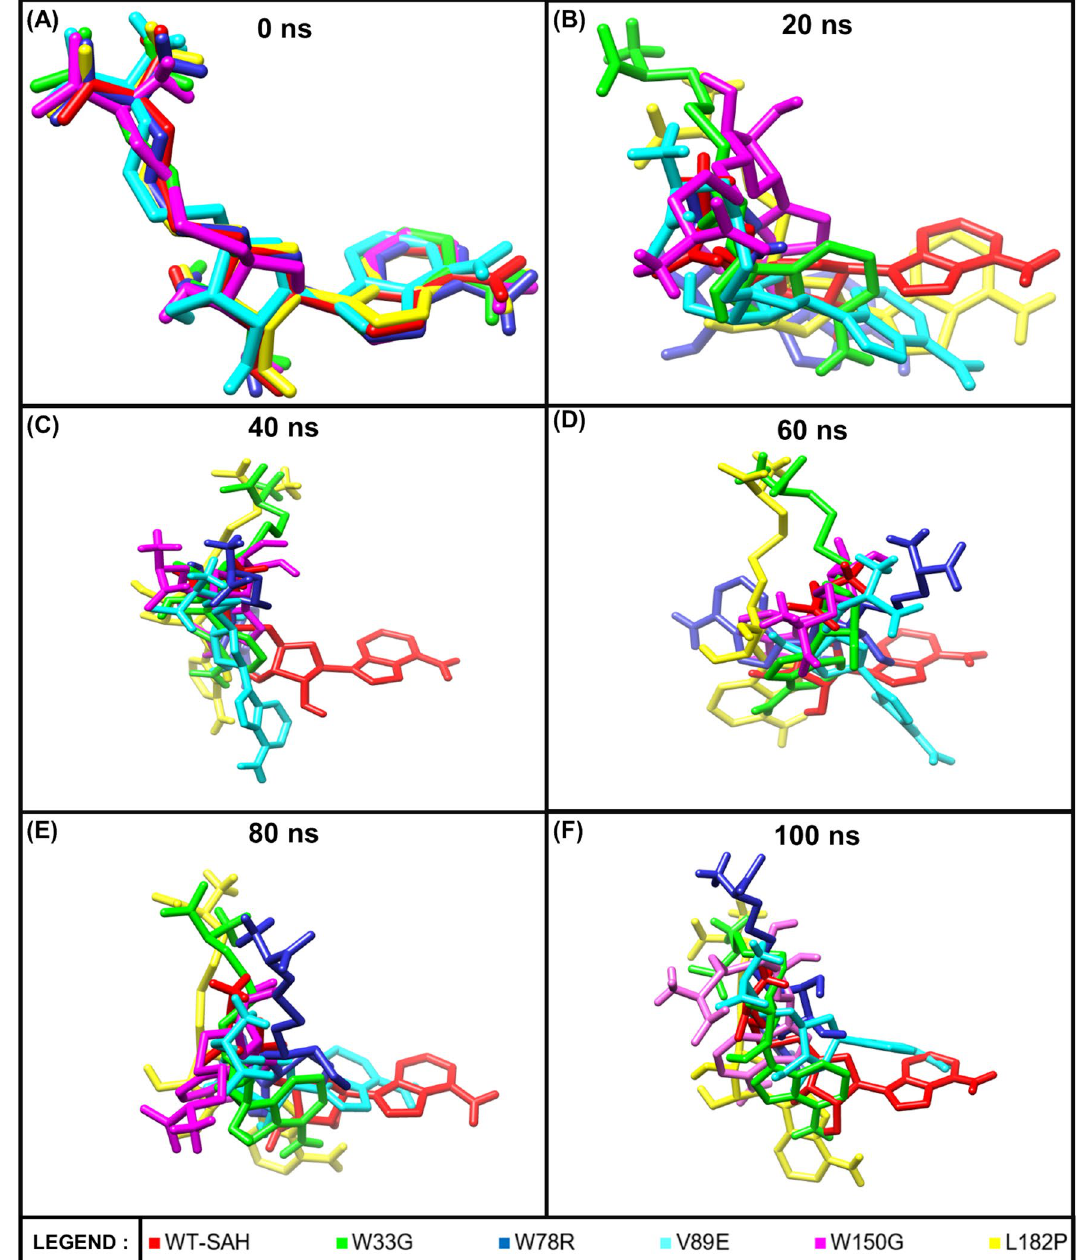
Figure 5. Ligand conformations for all six ligand-bound systems across 0, 20, 40, 60, 80 and 100 ns of simulation